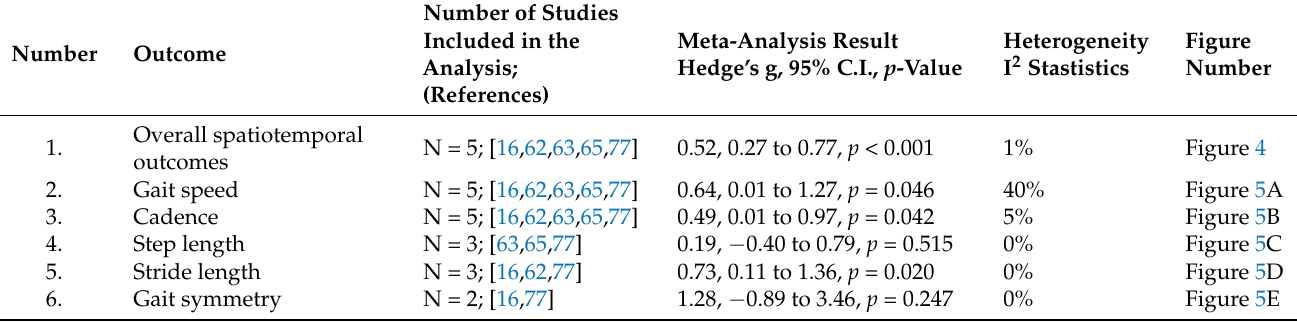
Table 4. Meta-analysis